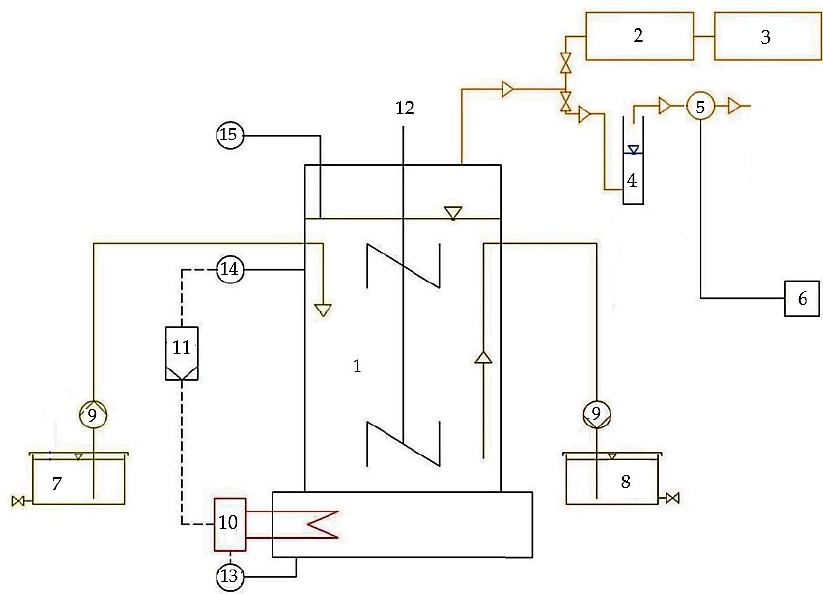
Figure 1. Schematic of the digester model: 1 — digester, 2 — biogas tank, 3 — biogas analyzer, 4 — liq- uid fuse, 5 — biogas flow meter, 6 — computer, 7 — feedstock tank, 8 — digested sludge tank, 9 — pump, 10 — heater, 11 — temperature controller, 12 — stirrer, 13 — thermal protection, 14 — tempera- ture measurement, 15 — pH